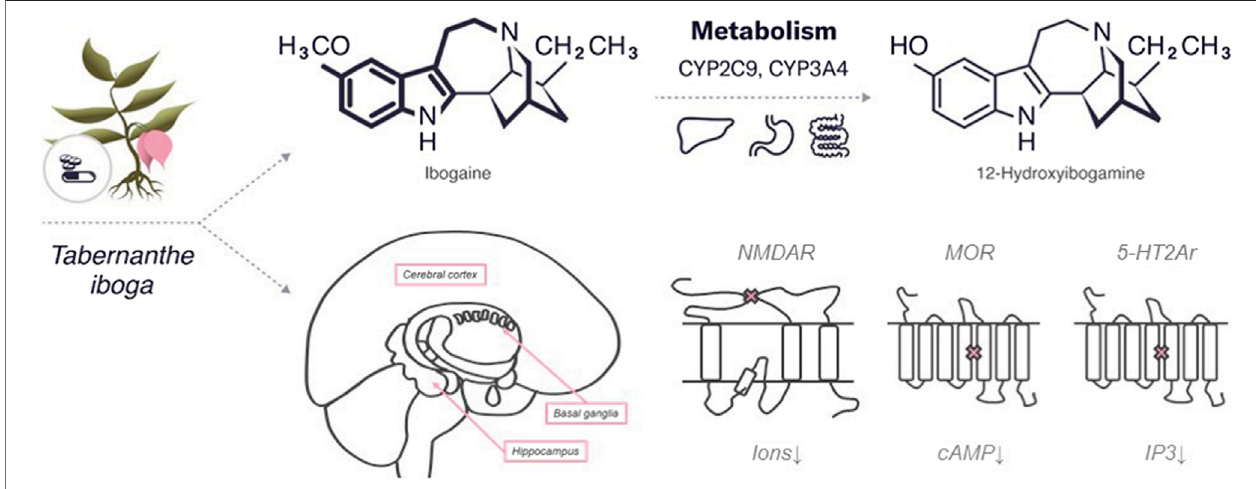
FIGURE 2 | An overview of the characteristics of